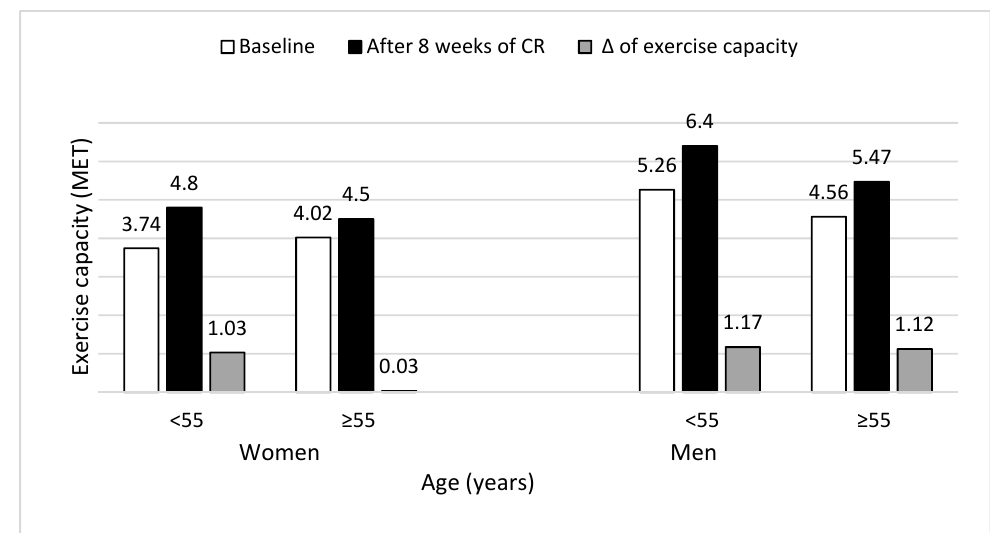
Figure 1. The exercise capacity of examined women and men with CAD at baseline and after 8 weeks of CR program in age subgroups.